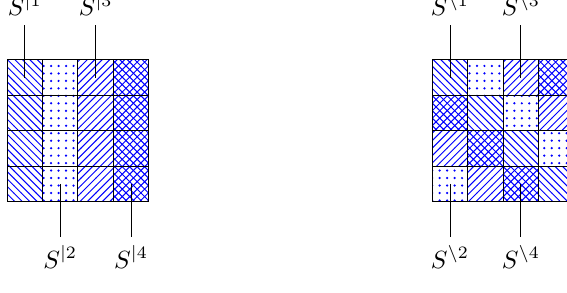
Figure 3: Column/diagonal notations S | i and S \ i .